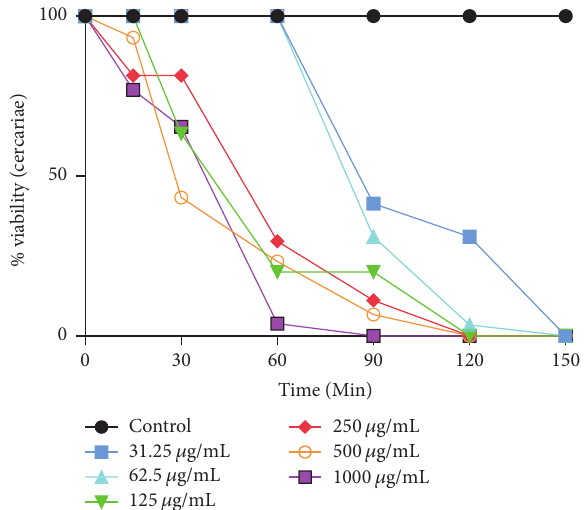
Figure 1:Effect of different concentrations of R. vomitoria stem bark on the viability of Schistosoma mansoni cercariae.